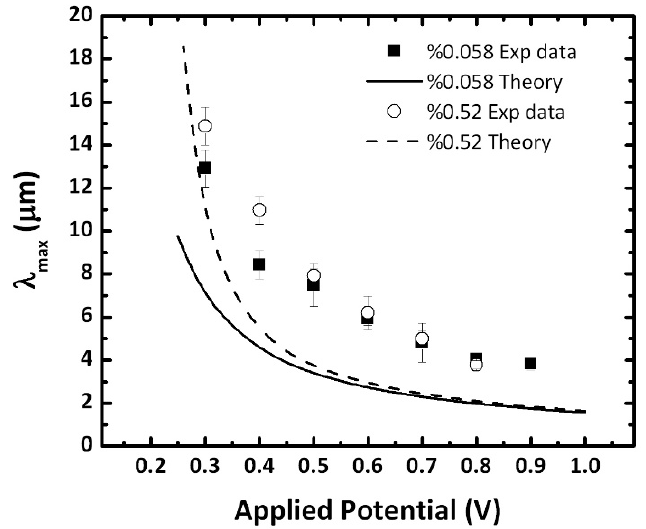
Figure 3. The dominant wavelength of the emulsion film for various applied potentials. The graph compares the calculated and measured dominant wavelengths for various field strengths.